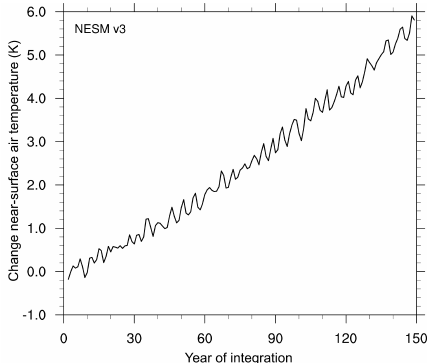
Figure 18. Results from the 1% per year CO 2 increase experiment. Global mean annual surface air temperature change relative to the counterpart in the PI experiment. The average temperature anomaly between years 60 and 80 is defined as transit climate sensitivity, which is 2.16K in NESM